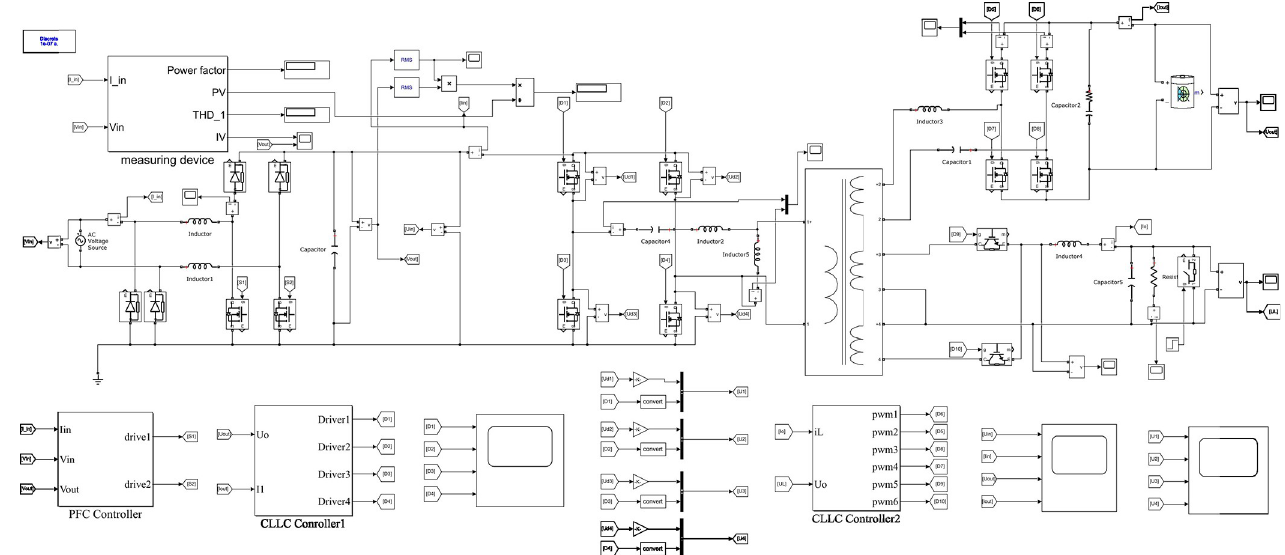
Fig 14. Simulation model of dual output port vehicle charging